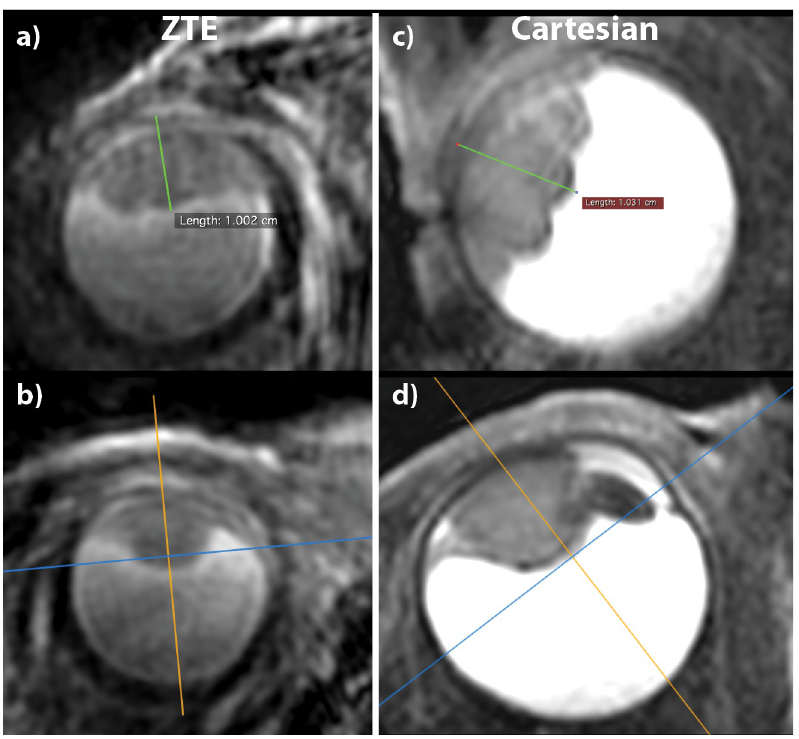
Fig 6. Tumor thickness measurements performed on the ZTE and Cartesian images of UM-patient 7. To measure the tumor thickness, defined as the distance between the top of the tumor and the outside of the sclera, a reformatting of the 3D MR-images is made perpendicular to the tumor (the orange plane in b,d)). On the resulting image, a) and c), the tumor thickness can be accurately measured. The corresponding measures of all patients can be found in Table 3.